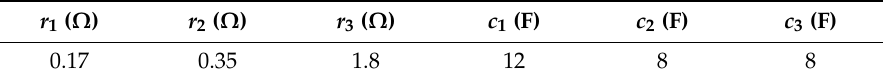
Figure 7. Comparison of the supercapacitor simulation results with the experimental data. Table 2. Supercapacitor equivalent circuit